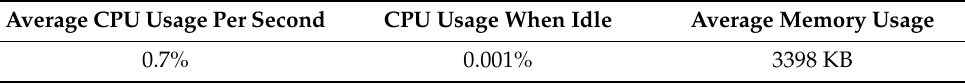
Table 6. Overhead generated by GWRMS daemon